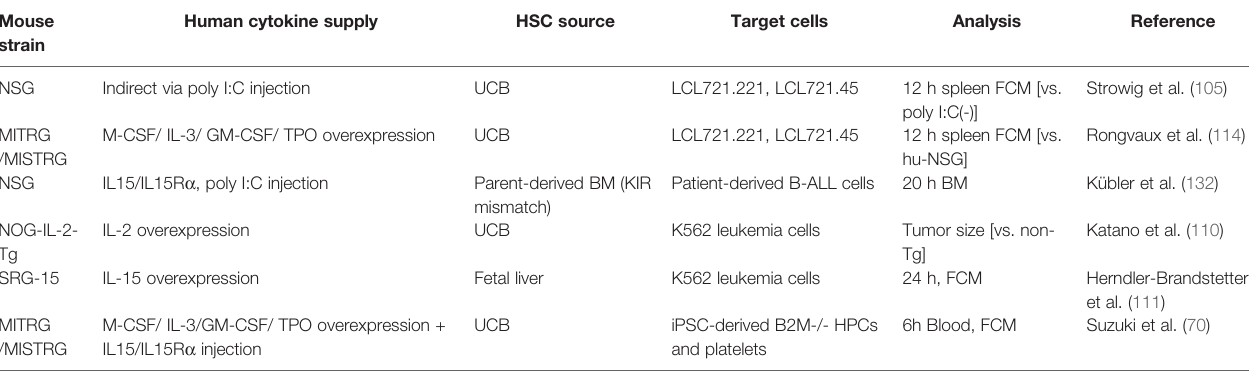
TABLE 2 | Rejection of HLA-de fi cient cells in HIS Hu-SRC mice in vivo . Mouse